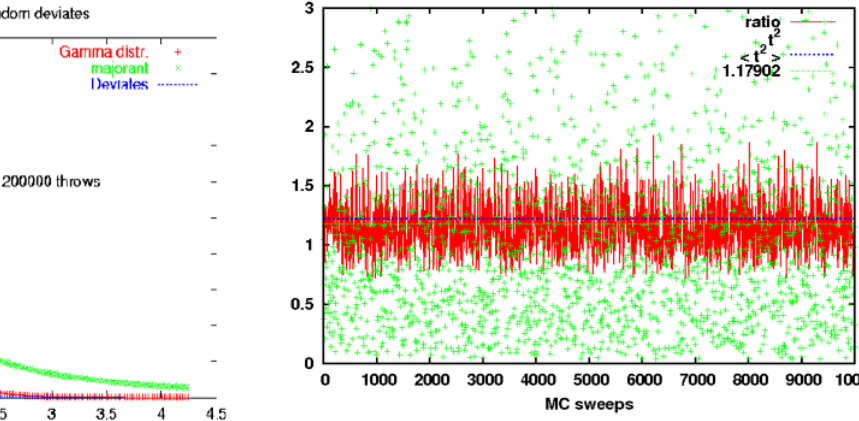
Fig. 3. The ratio at : b / t and the square of the asymmetry parame- ter t 2 (green crosses) as a function of the Monte-Carlo steps. The numerical average of t 2 and the theoretical expectation value is also